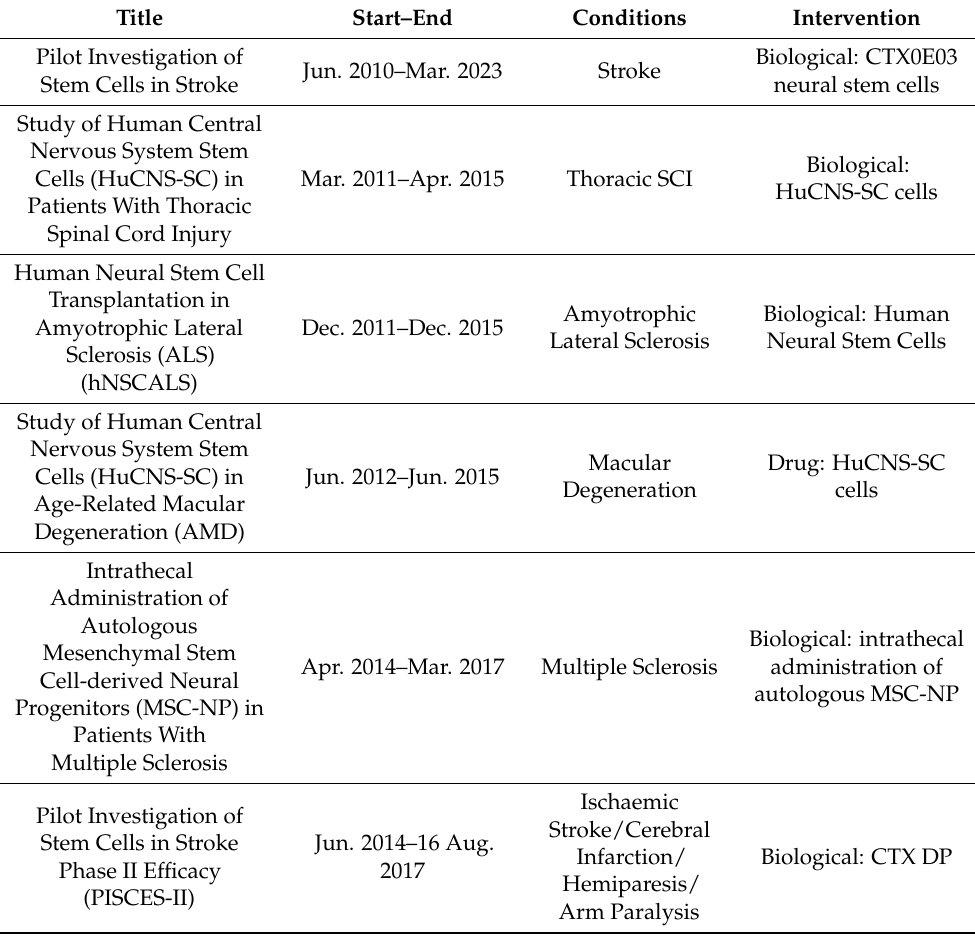
Table 3. NSPC-based clinical